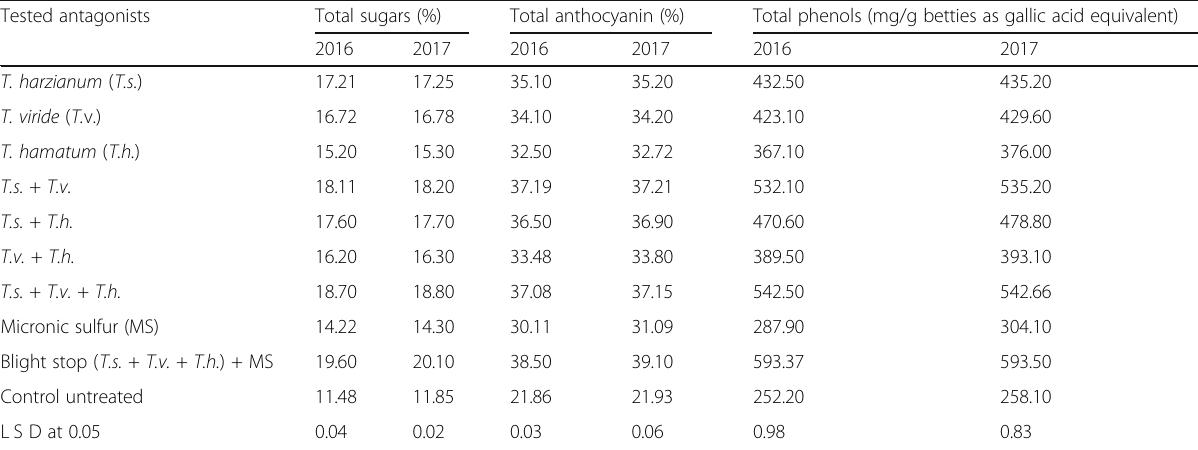
Table 4 Effect of different antagonists and micronic sulfur on total (sugars, anthocyanin, and phenols) of Thompson grapevine under Egyptian field conditions during 2016 and 2017 seasons Tested